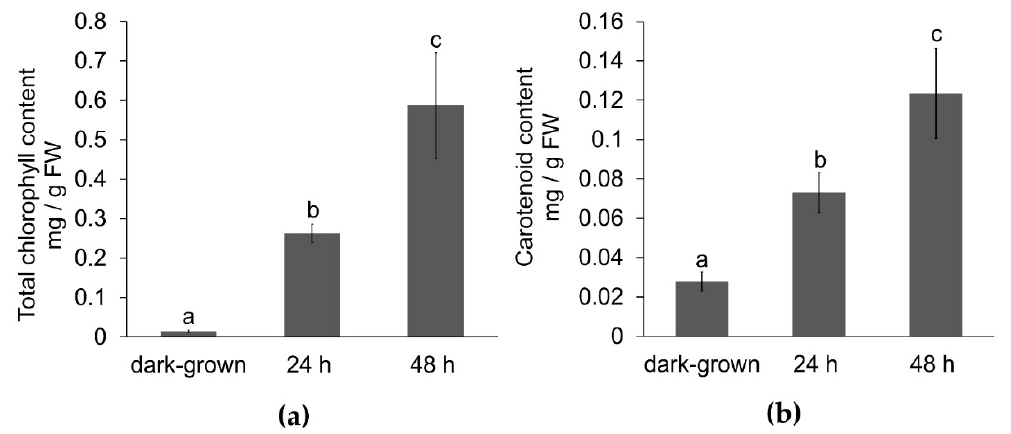
Figure 1. Total chlorophyll ( a ) and carotenoid ( b ) content in dark-grown chia microgreens and microgreens after exposure to light for 24 and 48 h. Data represent mean values from three experiments with five replicates (n = 15). The error bars show standard deviation (SD). Different letters signify values that are statistically different at p ≤ 0.05 according to Fisher’s LSD test.